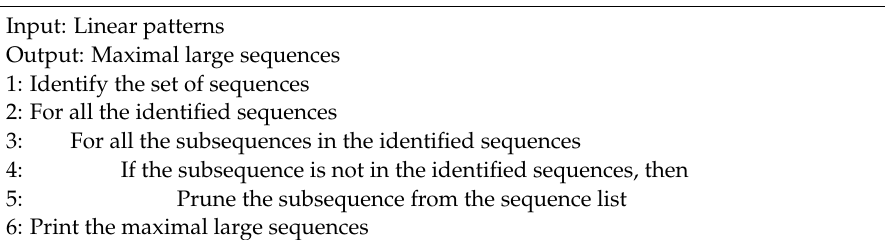
Algorithm 3 Proposed Linear Pattern Pruning